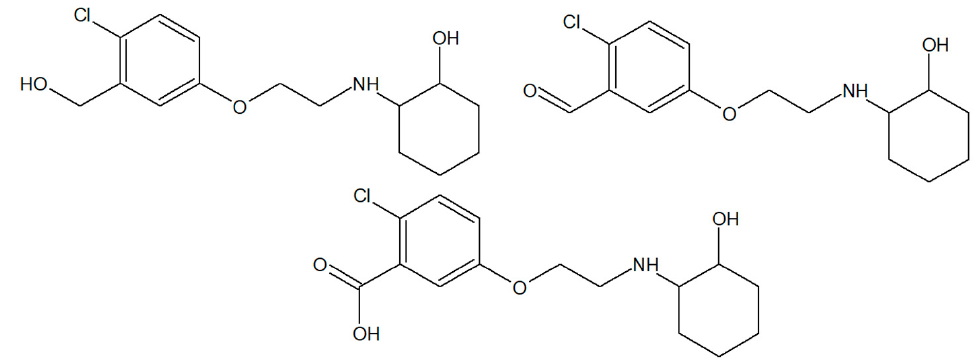
Figure 5. Chemical structures of the main metabolites of compounds 1 – 3 .